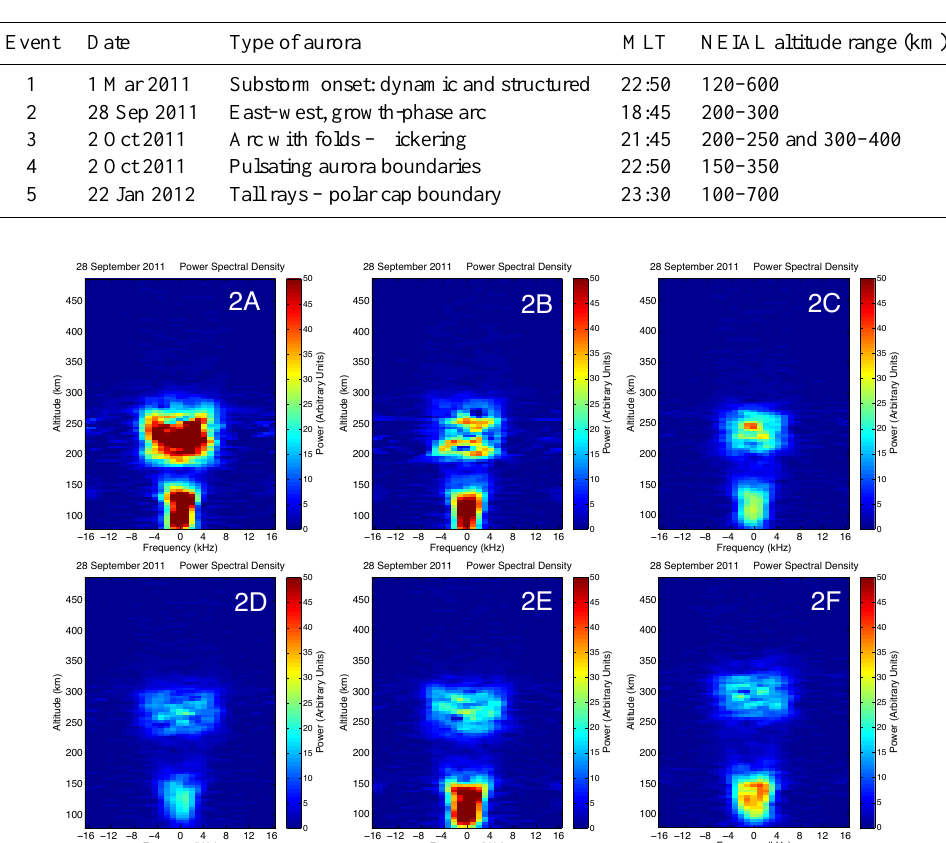
Figure 5. Event 2: NEIAL spectra from the times labeled 2A–2F in Fig. 4. There is little variation in the spectral features – other than intensity – between the 5-second integration periods during this event. There are no distinct spectral asymmetries and primarily enhanced power in the whole spectral range between the up- and downshifted ion-acoustic lines.